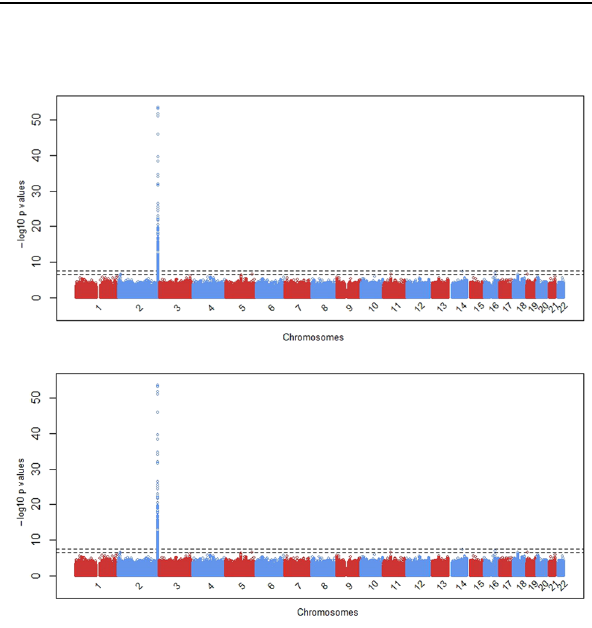
Fig. 1 GWAS Manhattan plot. The two dotted lines represent − 8 ) and − log − 7 ), respectively. − log 10 (5 × 10 10 (5 × 10